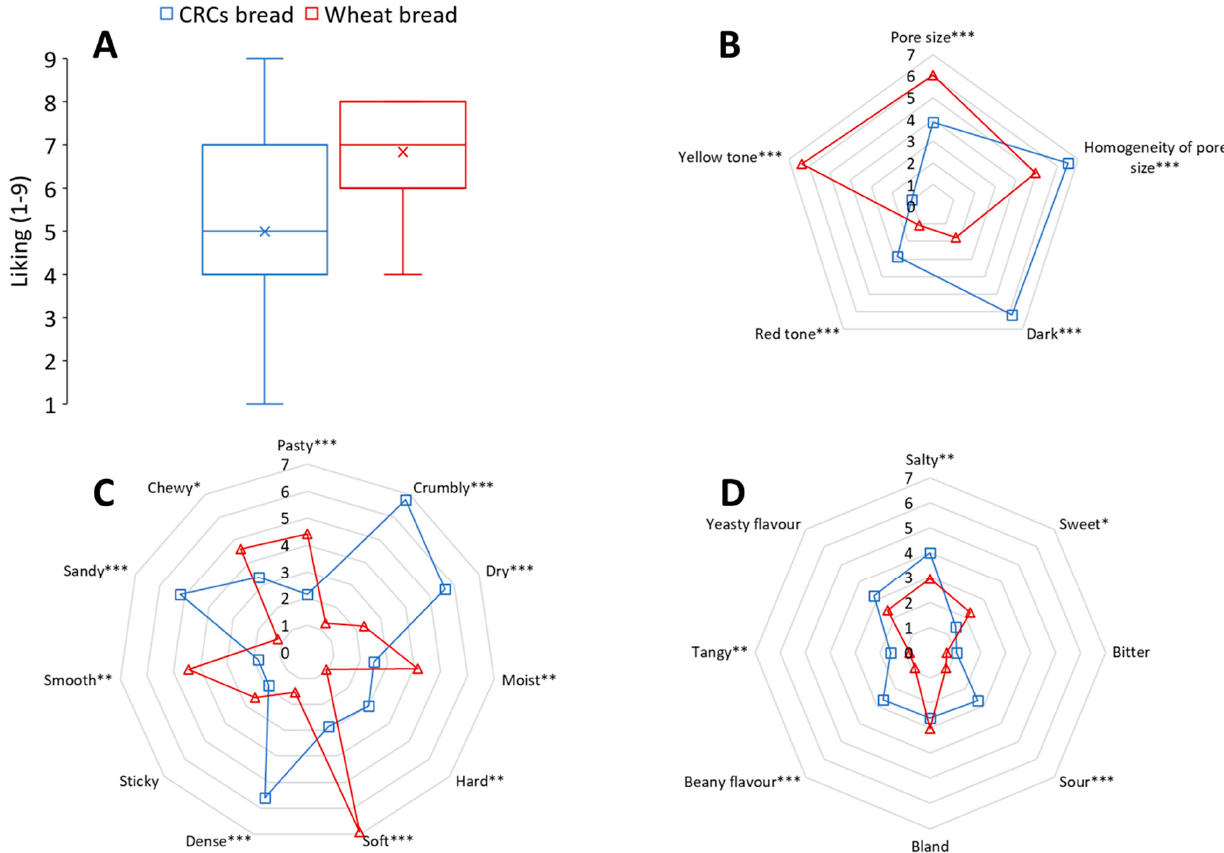
Figure 2. Overall acceptance of breads by consumers on a 1–9 scale ( A ) and comparison of the mean intensity scores for RATA test on a 0–9 point scale for attributes related to appearance ( B ), texture ( C ) and flavour ( D ). * p < 0.05, ** p < 0.01, *** p < 0.001.